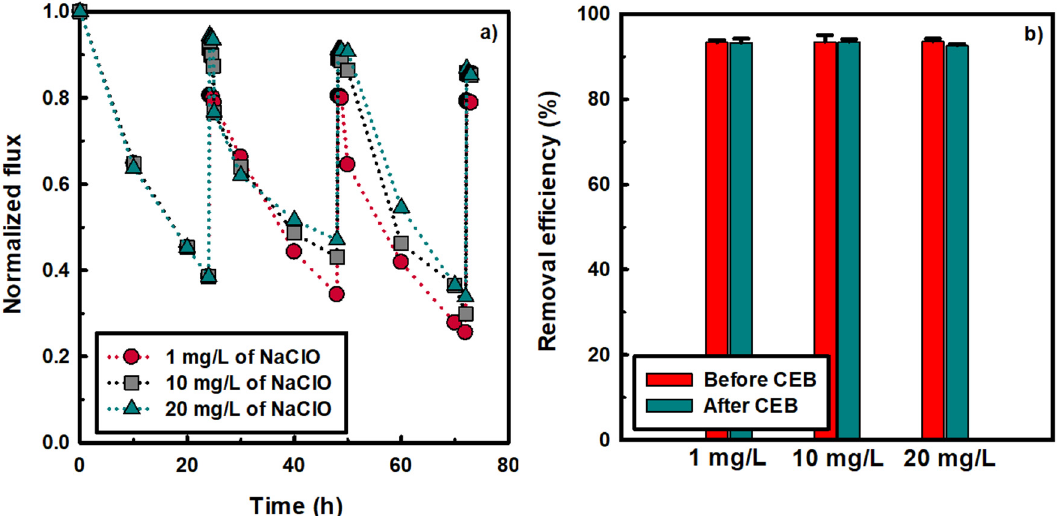
Figure 7. ( a ) Normalized permeate flux and flux recovery of the PAN-NF HF membrane during backwashing using different concentrations of NaClO as a function of time. ( b ) TOC removal efficiency of the PAN-NF HF membrane after backwashing with different concentrations of NaClO. Operating conditions: pressure = 5 bar; stirring speed = 300 rpm; cross-flow velocity = 1 L/min, conductivity = 300 μ S/cm; backwashing pressure: 1 bar; backwashing period: 30 s; and temperature = 25 °C.